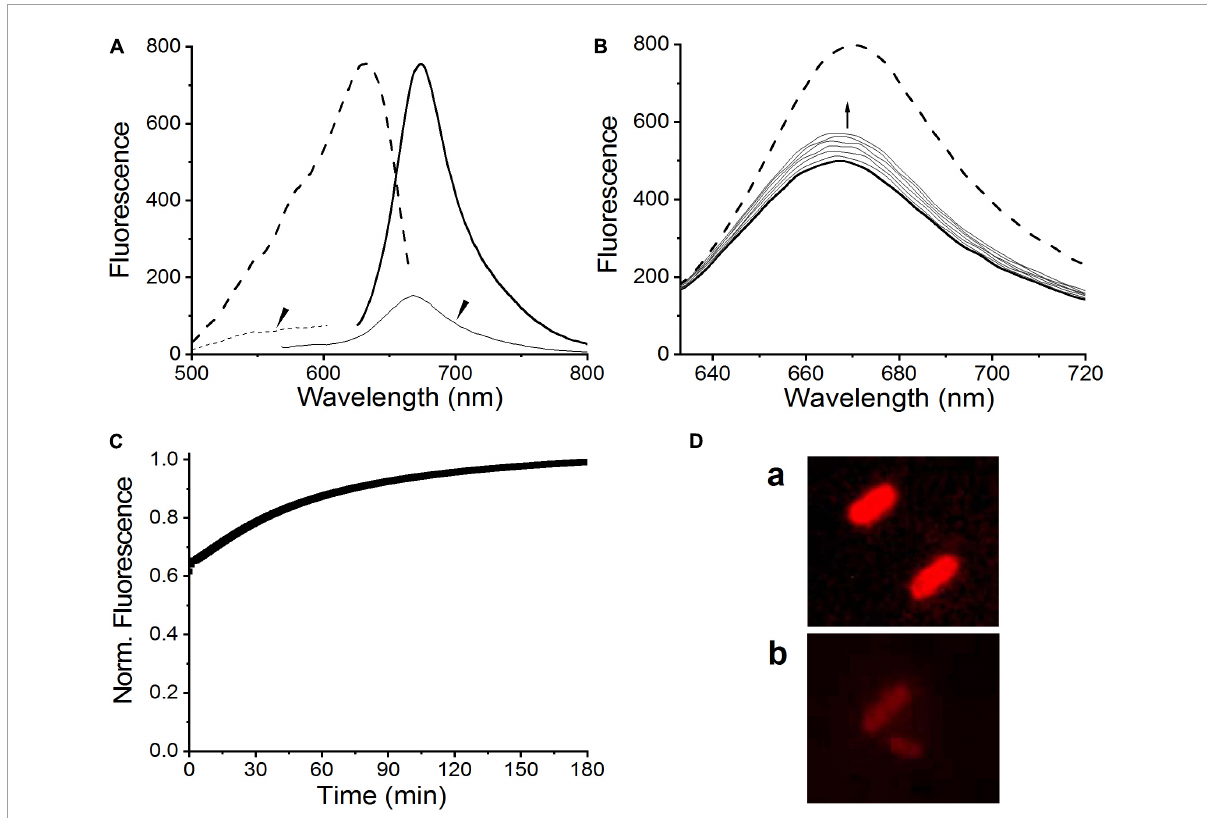
FIGURE5 Fluorescence properties of C448S_CY. (A) Fluorescence excitation (dashed lines) and fluorescence emission spectra (solid lines) of the C448S_CY Pr state (heavy lines) and the C448S_CY Po state (thin solid lines indicated by the arrow). (B) Fluorescence spectra of C448S_CY acquired at the indicated times during dark reversion; and (C) fluorescence intensity at 672 nm during dark reversion. The dashed line indicates fluorescence emission spectra of the 15Z state obtained before irradiation. (D) Fluorescence images of E. coli cells expressing C448S_CY (a) and C448S (b)